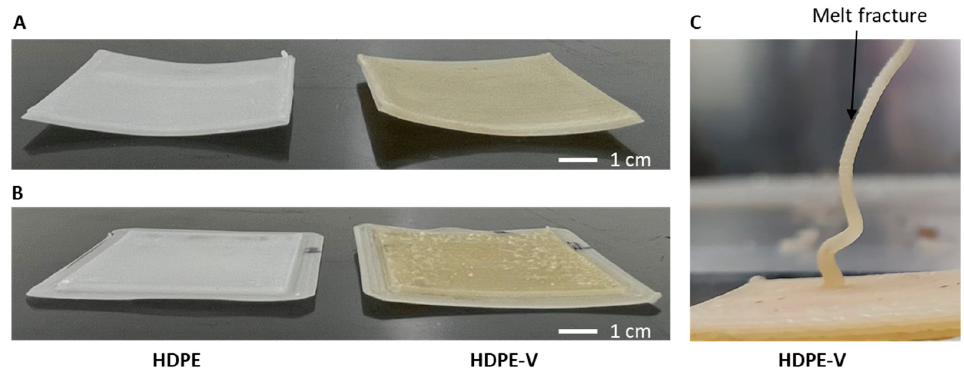
Figure 5. Square plates (60 mm × 60 mm × 3 mm) produced ( A ) without brims and ( B ) with brims. ( C ) Melt fracture observed in HDPE-V.